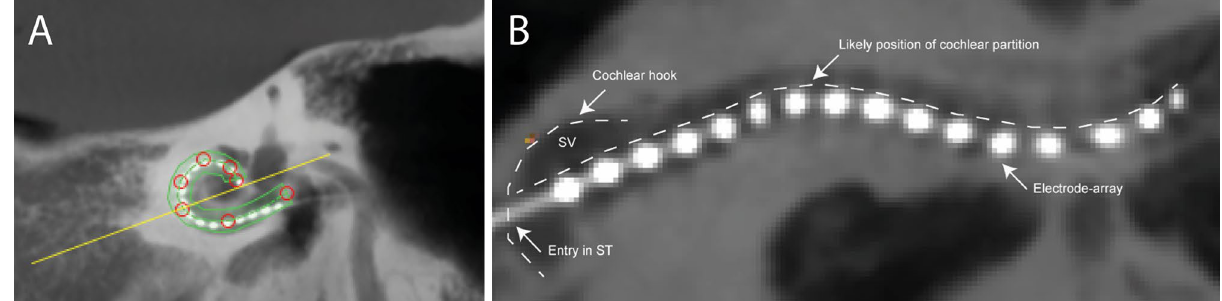
Figure 12. Method for uncoiled cochlear reconstructions (UCR). ( A) line is drawn along the implanted array in the oblique ‘cochlear view’ reconstruction with 2 mm thickness. The red circles depict the manually selected points that were used to trace the array. The yellow line shows the cross section perpendicular to this tracing line. ( B ) Subsequently, these reconstructions generated a planar two-dimensional image with implanted